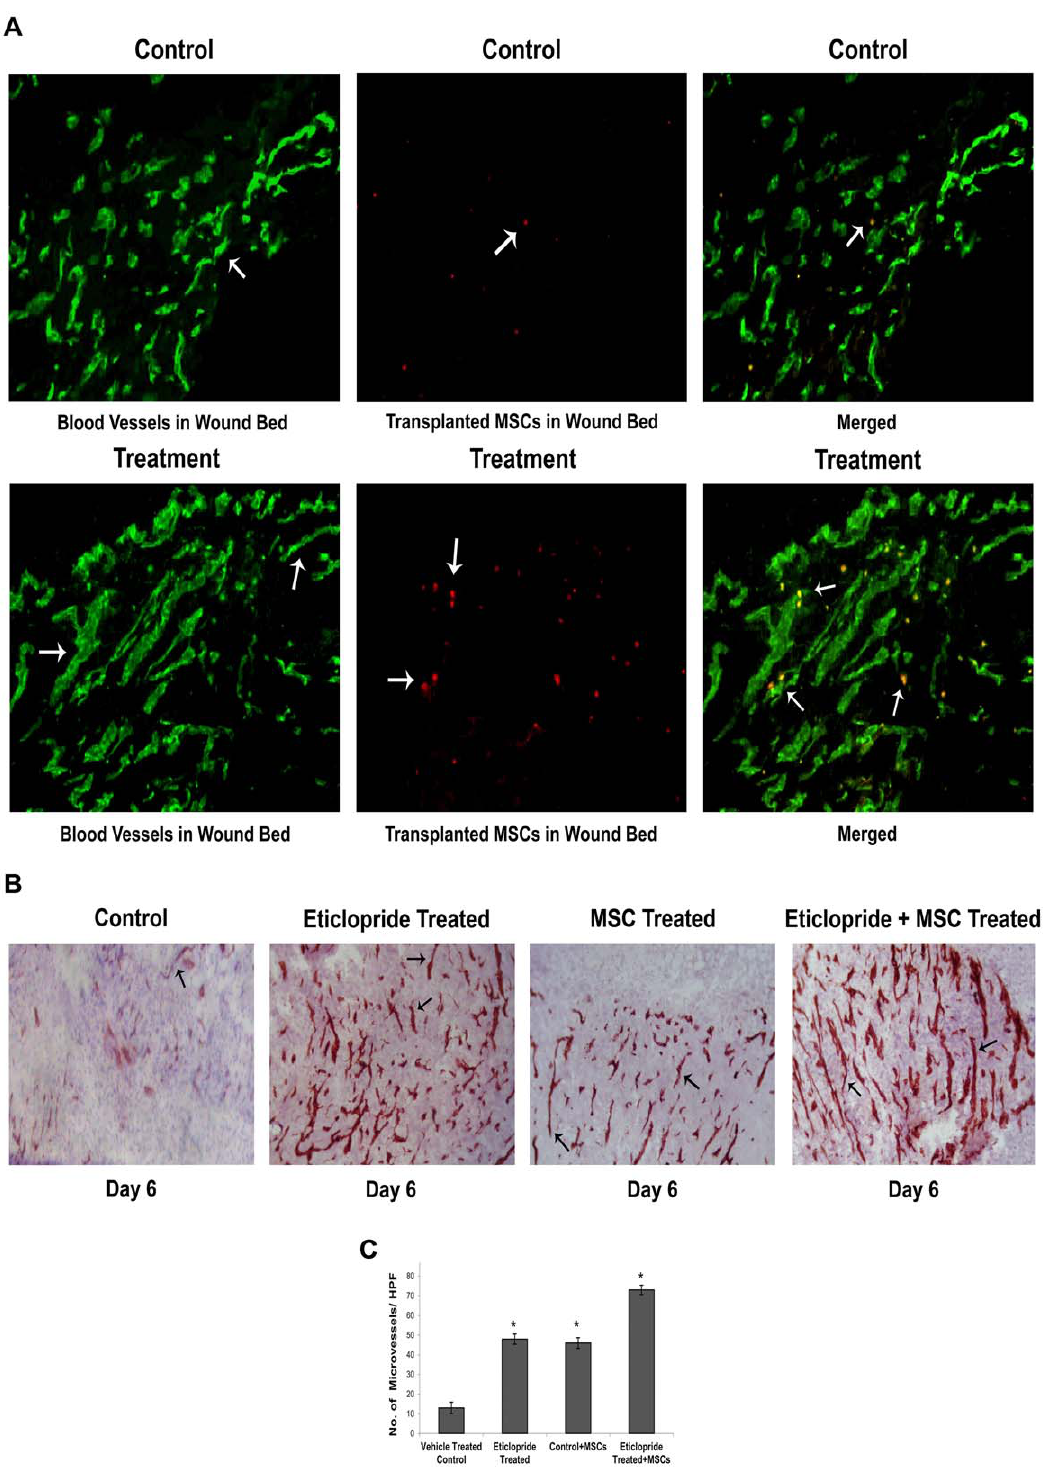
Figure 3. Dopamine (DA) D 2 receptor antagonist treatment stimulate incorporation of MSCs into neovessels of wound bed and subsequent angiogenesis in wound bed. ( A ) Effect of eticlopride treatment on incorporation of transplanted MSCs into newly formed blood vessels in wound bed. MSCs were labeled with CM-Dil and injected into the tail vein of both control and eticlopride treated back skin-injured mice. At day 6, the skin from the wound area was collected and sectioned with cryomicrotome. Frozen sections were immunostained with anti-CD31 antibody and FITC-conjugated secondary antibody and analyzed to determine the extent of incorporation of transplanted MSCs into blood vessels. Here co- localization study showed that exogenously transplanted MSCs, labeled with fluorescent dye CM-Dil (red in colour), had integrated into the newly formed blood vessels (green in colour) in wound site in much greater number following DA D 2 receptor antagonist treatment than vehicle treated controls. Original magnifications, 6 200. ( B ) Effect of MSC transplantation on formation of new blood vessels in wound bed. Immunohistochemical